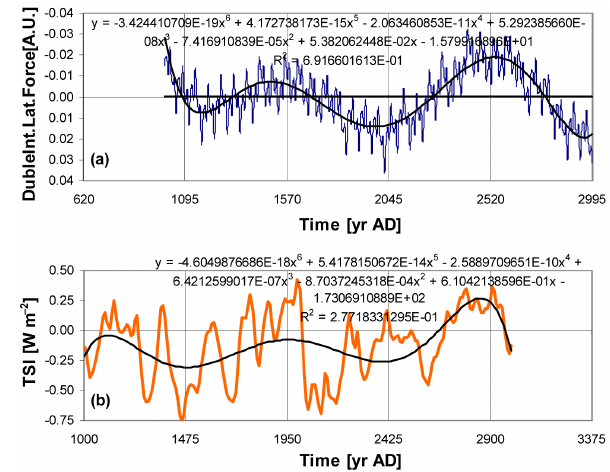
Figure B5. A comparison of the double integral of the solar lat- eral inertial forces σF 2 ( t ) and the solar reconstructed and extrap- olated record TSI. To enhance trends, polynomials are adjusted to both records, showing oscillations of ∼ 950 years and a lag of ∼ 350 years.